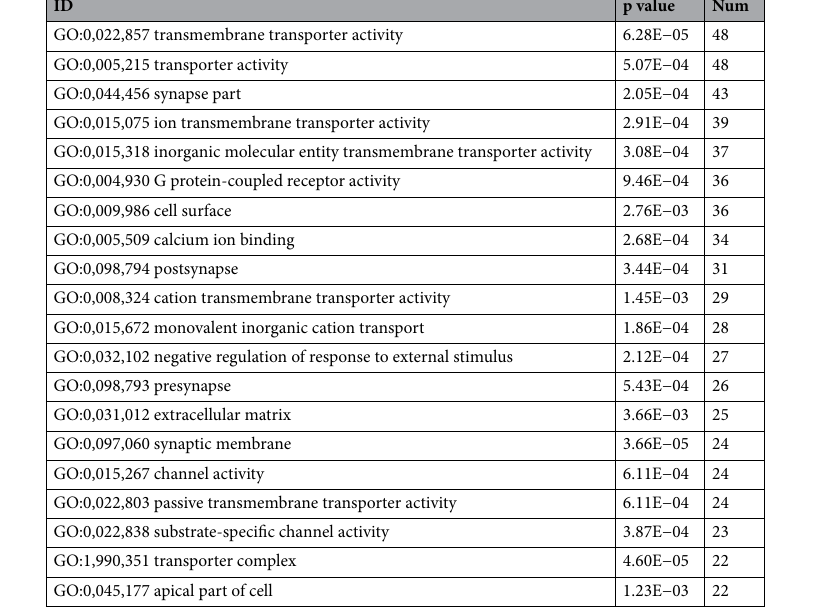
Table 2. The GO TOP20 analysis of the differentially expressed genes.